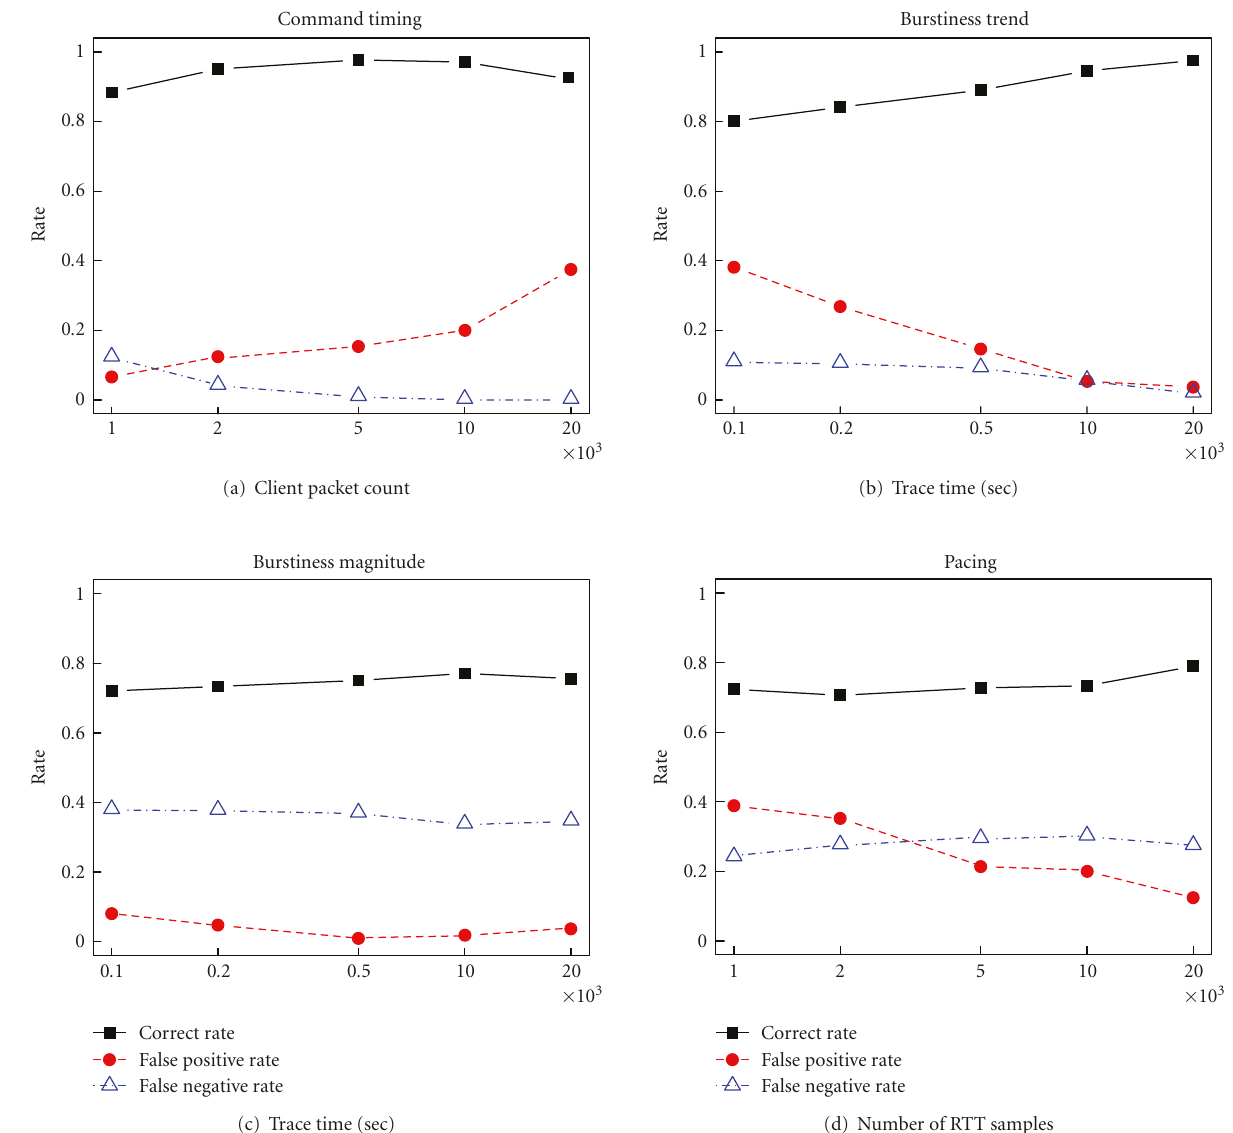
Figure 18: Evaluation results for the proposed decision schemes with di ff erent input